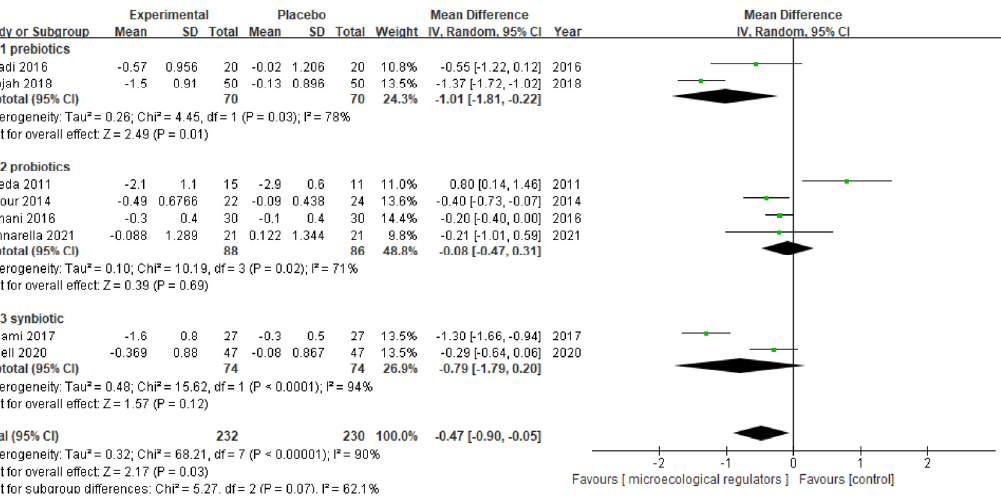
Figure 4. Forest plot of disease activity score (DAS28) variations in rheumatoid arthritis [36,37,39,40,43–46].